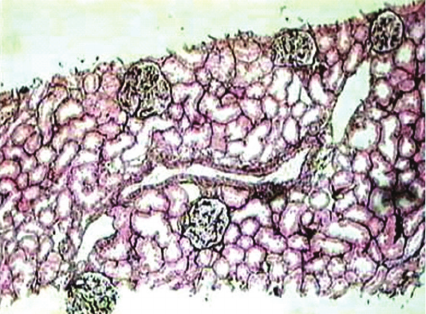
Figure 2: Low-power view of a representative section of a renal bio- psy showing five glomeruli with minor changes. There is no seg- mental scarring or significant mesangial proliferation. One small artery included as well as the surrounding tubulointerstitial com- partment show no significant pathology. This case was diagnosed as minimal change disease after IF study showed negative results and EM showed di ff use e ff acement of foot processes. (Silver stain, ×